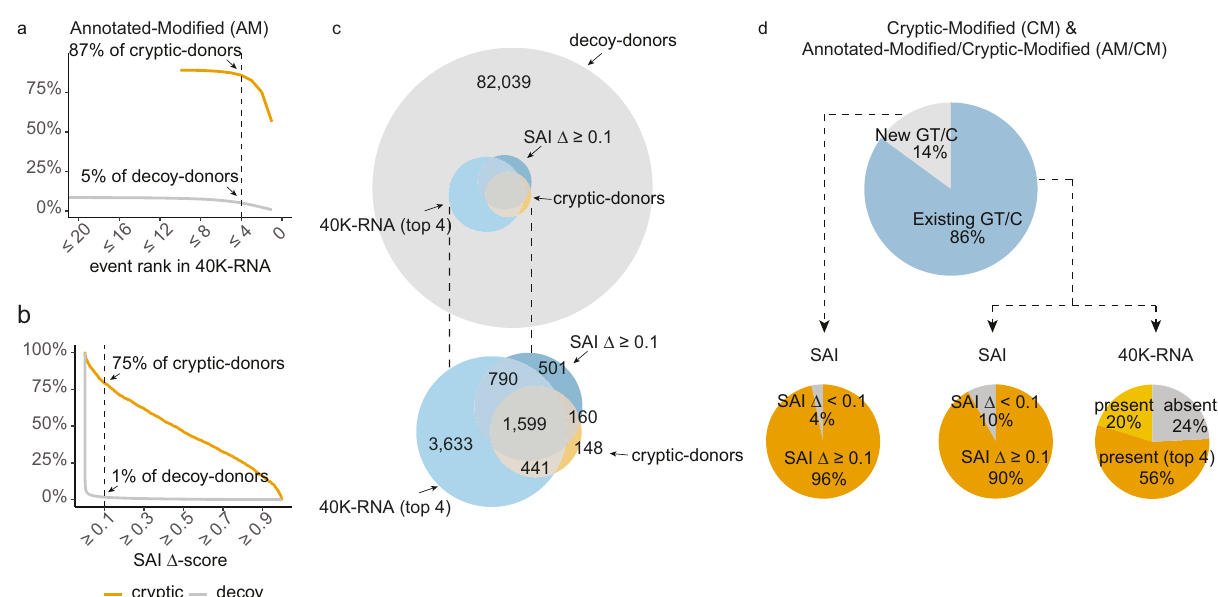
Fig. 6 40K-RNA potently informs cryptic-donor activation. a , b The percentage of Authentic-Modi fi ed (AM) cryptic-donors correctly predicted, and decoy-donors incorrectly predicted at different cut-offs for ( a ) event rank in 40K-RNA and ( b ) SpliceAI (SAI) Δ score (donor VAR -donor REF ). a The dotted line denotes cryptic- and decoy-donors predicted using a cut-off of events ranked 4 or less. 87% of cryptic-donors activated by AM-variants are among the top 4 events present in 40K-RNA within 250 nt of the annotated-donor, with 95% of decoy-donors not in the top 4 events. b While SpliceAI (SAI) outperforms other algorithms using a cut-off of Δ scores 0.1 and above (see supplementary Fig. 6a), it predicts only 75% of cryptic-donors (SAI Δ ≥ 0.1). SAI accurately excludes 99% of decoy-donors. c (top) Venn diagram showing the overlap of cryptic-donors with those predicted by SAI or our 40K-RNA method, among the entire pool of decoy-donors. (bottom) magni fi cation of internal Venn. d Cryptic-donors activated by CM- and AM/CM-variants. (top) New GT/C (Light grey) denotes variants creating a GT or GC essential splice-site motif (40K-RNA is inherently unsuitable for these variants). Existing GT/ C (blue) denotes variants that modify a decoy-donor with a pre-existing GC or GT essential splice-site. (bottom) For 40K-RNA, the orange segment denotes cryptic-donors in the top 4 events, yellow segment denotes where the cryptic-donor is present in 40k-RNA but is not in the top 4 events, and grey denotes cryptic-donors absent from